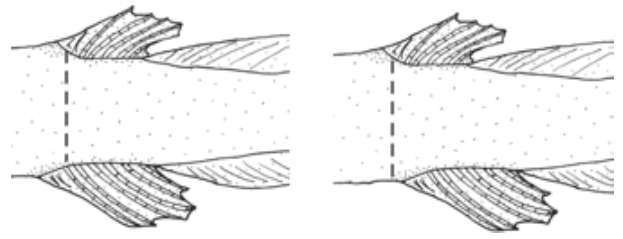
Fig. 5. Scheme of anal-fin origin in relation to dorsal-fin origin of Listrura costai , new species, showing the anteriormost (left) and posteriormost (right) positions of anal fin.